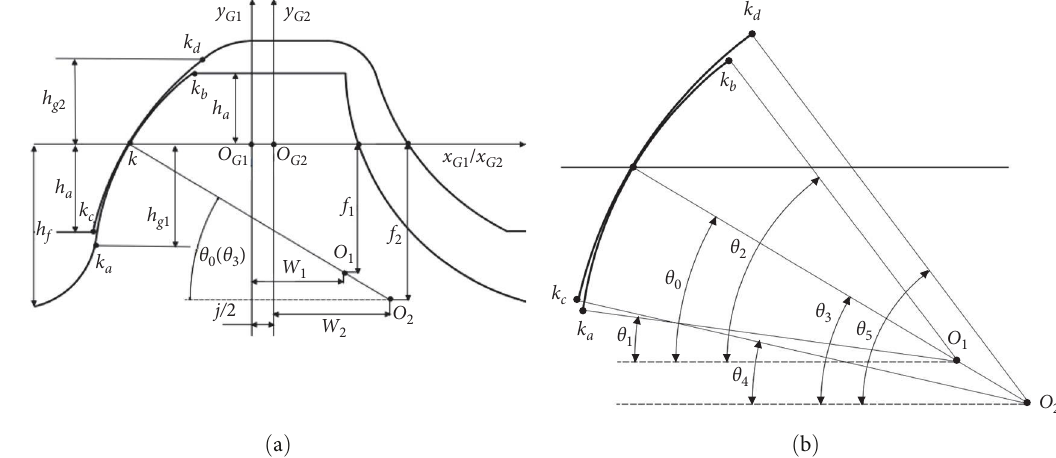
F IGURE 8: Meshing pro fi les of the asymmetric logarithmic spiral gear.